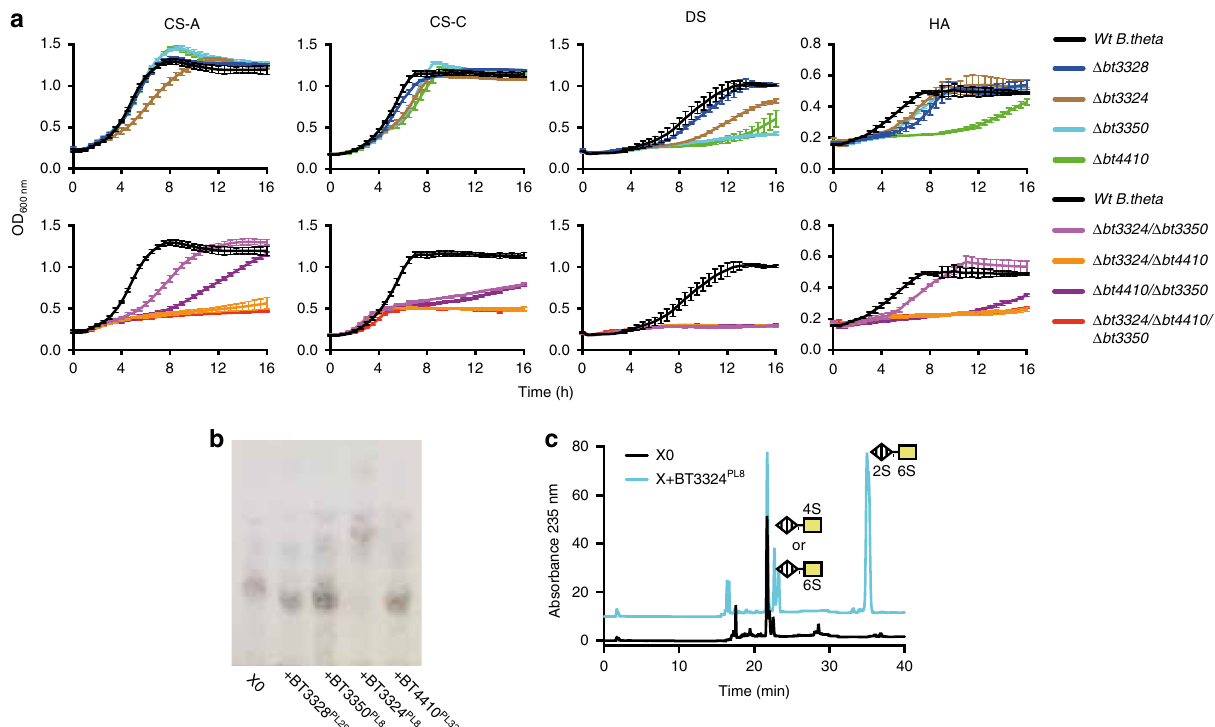
Fig. 3 Analysis of genetic knockouts and their effect on glycosaminoglycan metabolism. a Growth of genetic knockouts on glycosaminoglycan substrates (CS-A chondroitin sulfate A, DS dermatan sulfate, CS-C chondroitin sulfate C and HA hyaluronic acid); b TLC analysis of puri fi ed oligosaccharide (X), left behind in media from Δ bt3324 growths, against PUL CS/DS/HA encoded lyases; c HPLC analysis of X treated with BT3324 PL8 . Data represent technical triplicates and source data are provided in the source data fi le labelled as mutant (Supplementary Table 2). BT3350 PL8 displayed an endo mode of